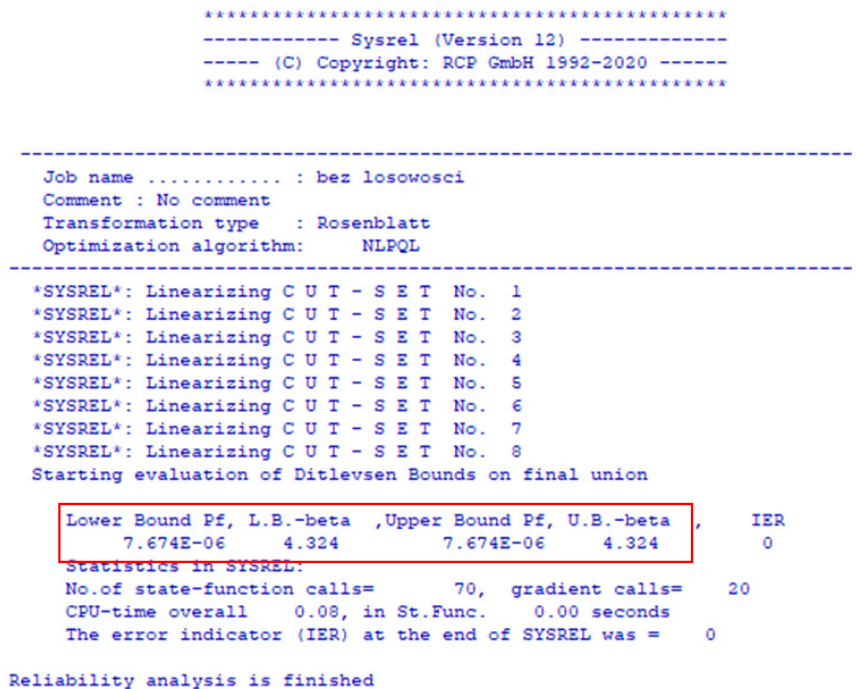
Figure 7. Results of the reliability analysis in the SYSREL program for the simplified model.